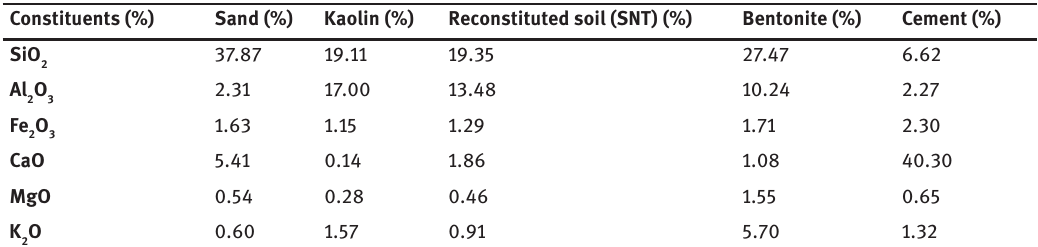
Table 1: Chemical compositions of the different soils used. Constituents (%)